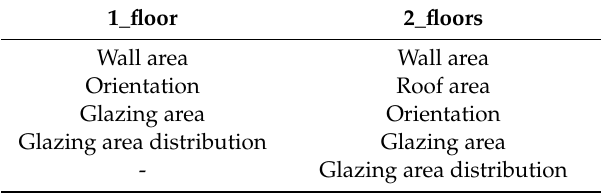
Table 6. Input variables for the 1_floor and 2_floors models of the heating load